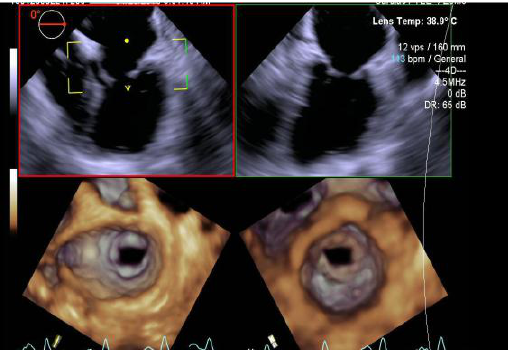
Figure 1 . Trans esophageal echocardiography severe MS and severe pulmonary artery hypertension up to 70 mmHg. Interatrial septum was aneurysmal. No obvious vegetation was seen in TEE.